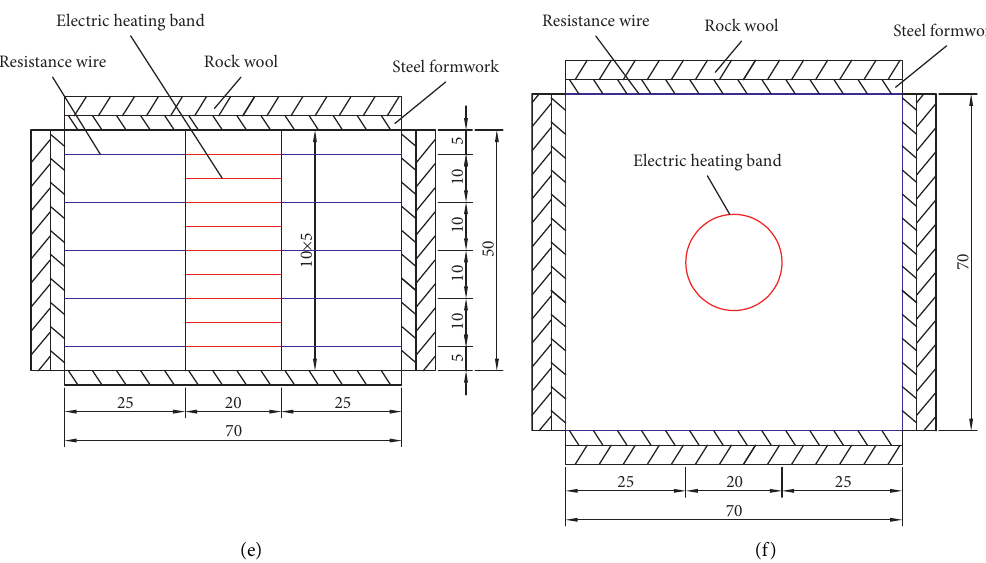
Figure 1: Schematic diagrams of test specimens (cm): (a) front view of specimen 1, (b) front view of specimen 2, (c) front view of specimen 3, (d) top view of specimen 3, (e) front view of specimen 4, and (f) top view of specimen 4.